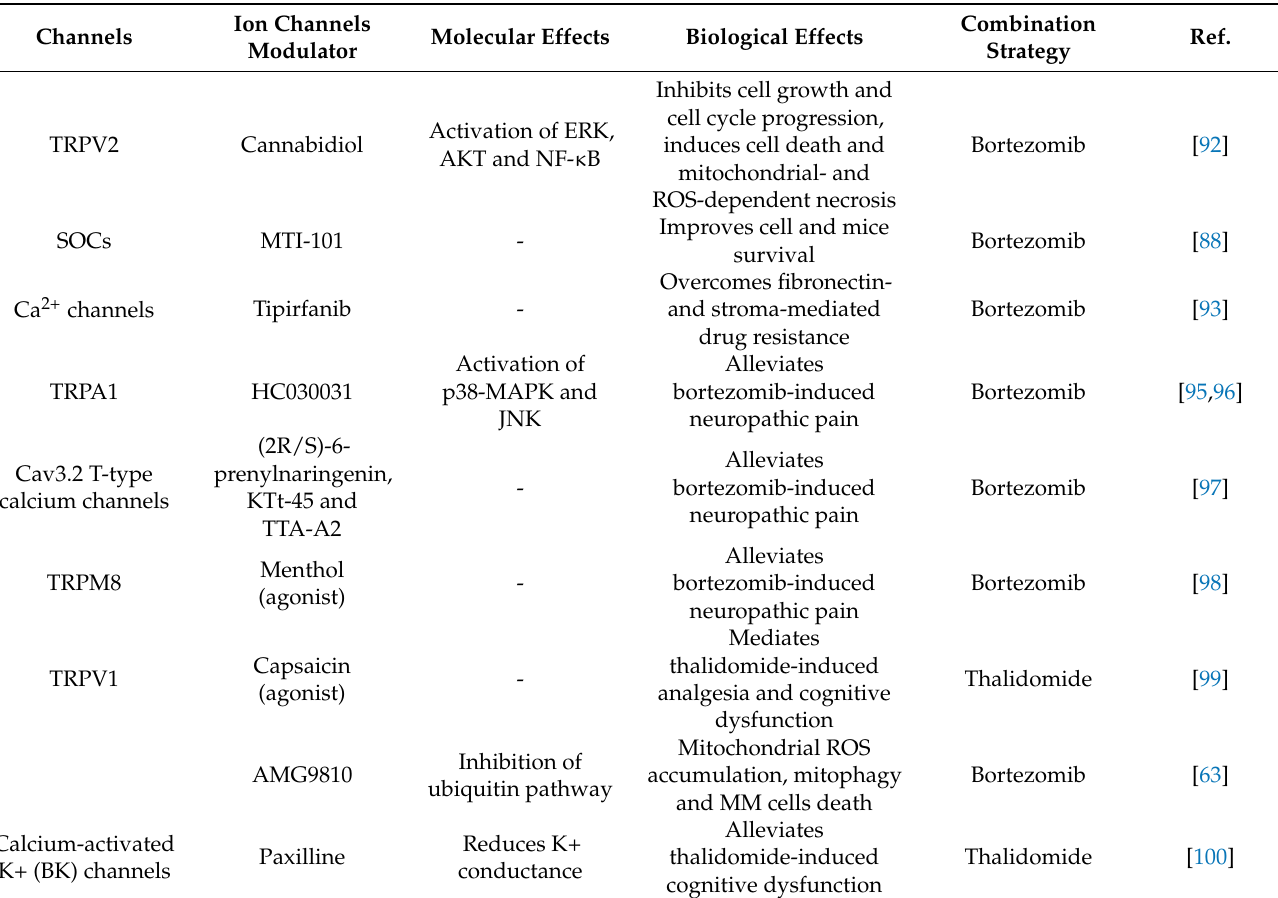
Table 1. Therapeutic perspectives of modulation of ion channel activity with agonist and/or antago- nist/inhibitor molecules for the treatment of MM